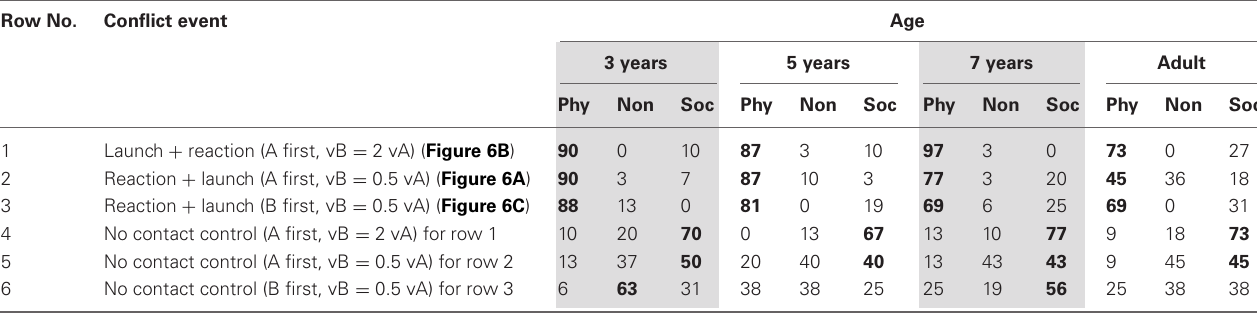
Table 4 | Percentage of physically causal, non-causal, and socially causal attributions, in 4 age groups, for 3 events combining contact motion and motion-at-a-distance, and for 3 control events with the same temporal pattern, but without contact in Experiment 4. Row